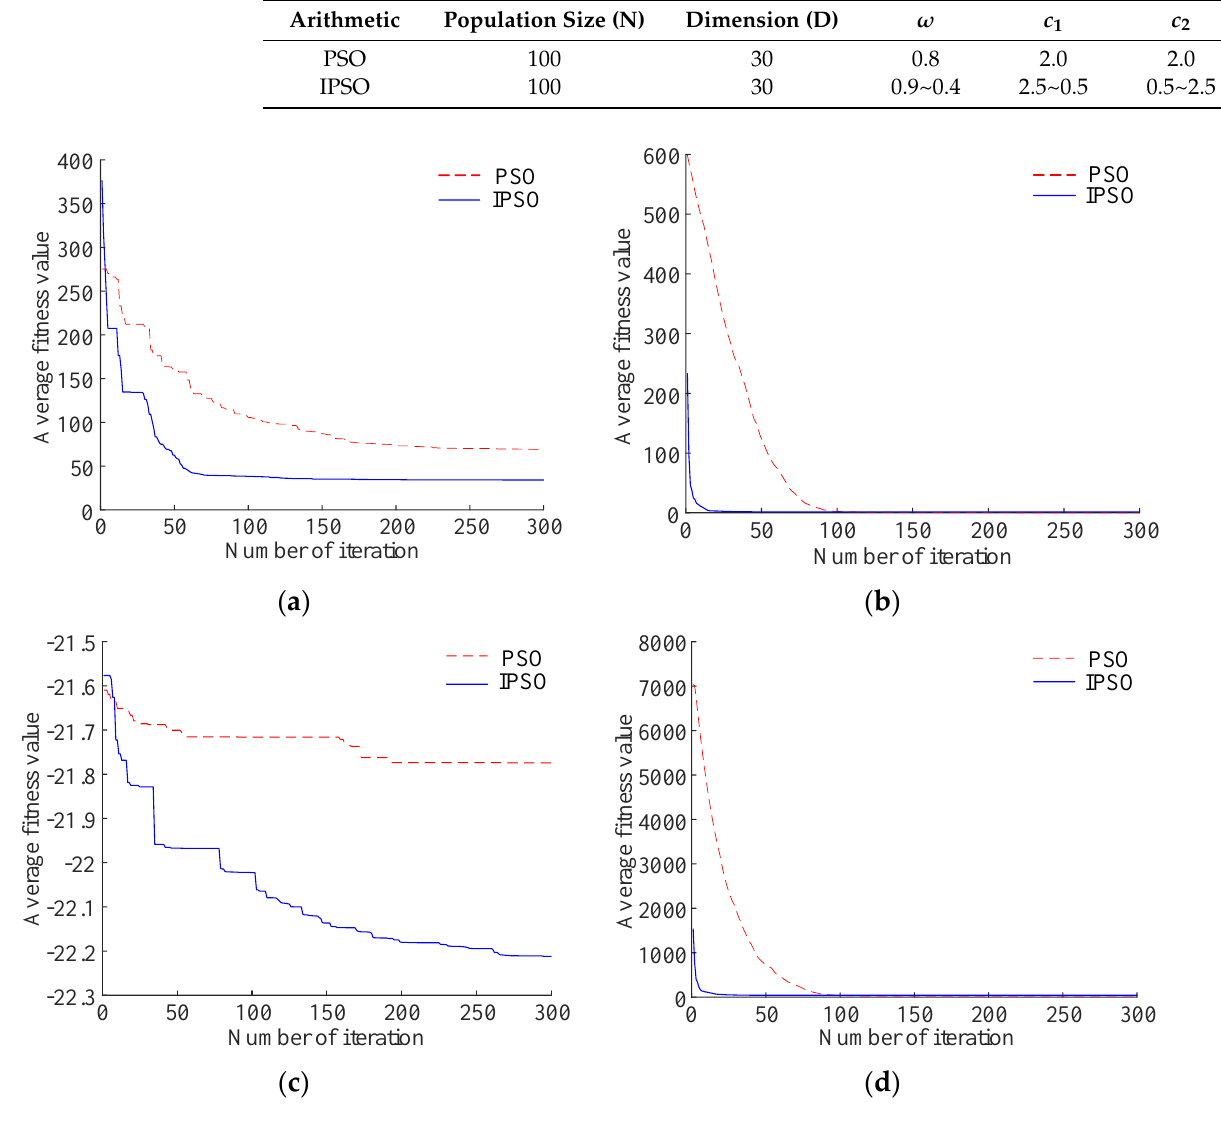
Figure 1. PSO and IPSO optimization results. ( a ) Fitness value under Rastrigin test function. ( b ) Fitness value under Griewank test function. ( c ) Fitness value under Acklet test function. ( d ) Fitness value under Rosenbrock test function.